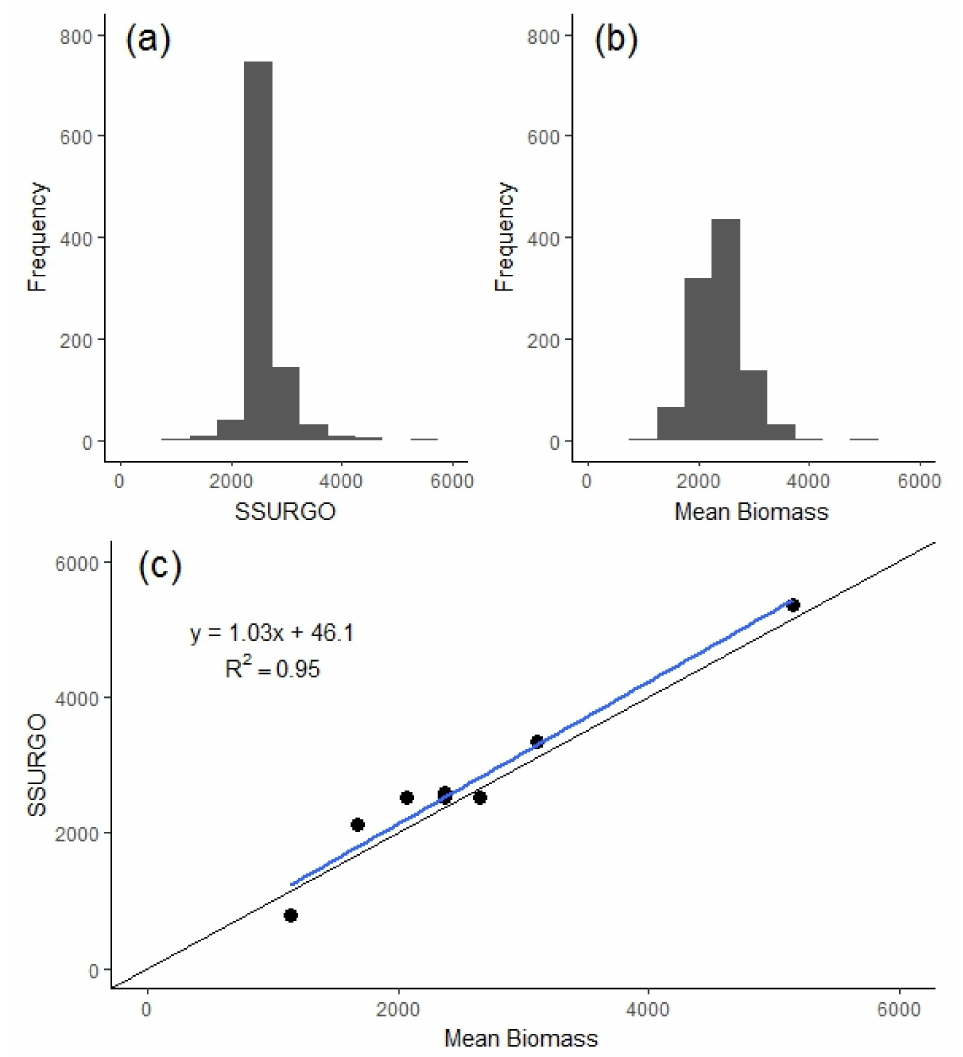
Figure 8. Histogram of SSURGO biomass ( a ) and mean EB for 2000–2016 ( b ), and ( c ) a regression of regional statistics derived from those two datasets (minimum, 5th percentile, 1st quantile, mean, median, 3rd quantile, 95th percentile, maximum). The blue line represents regression and the black line shows the 1:1 relationship between SSURGO and mean biomass. SSURGO and mean biomass are displayed in kg*ha − 1 *yr − 1